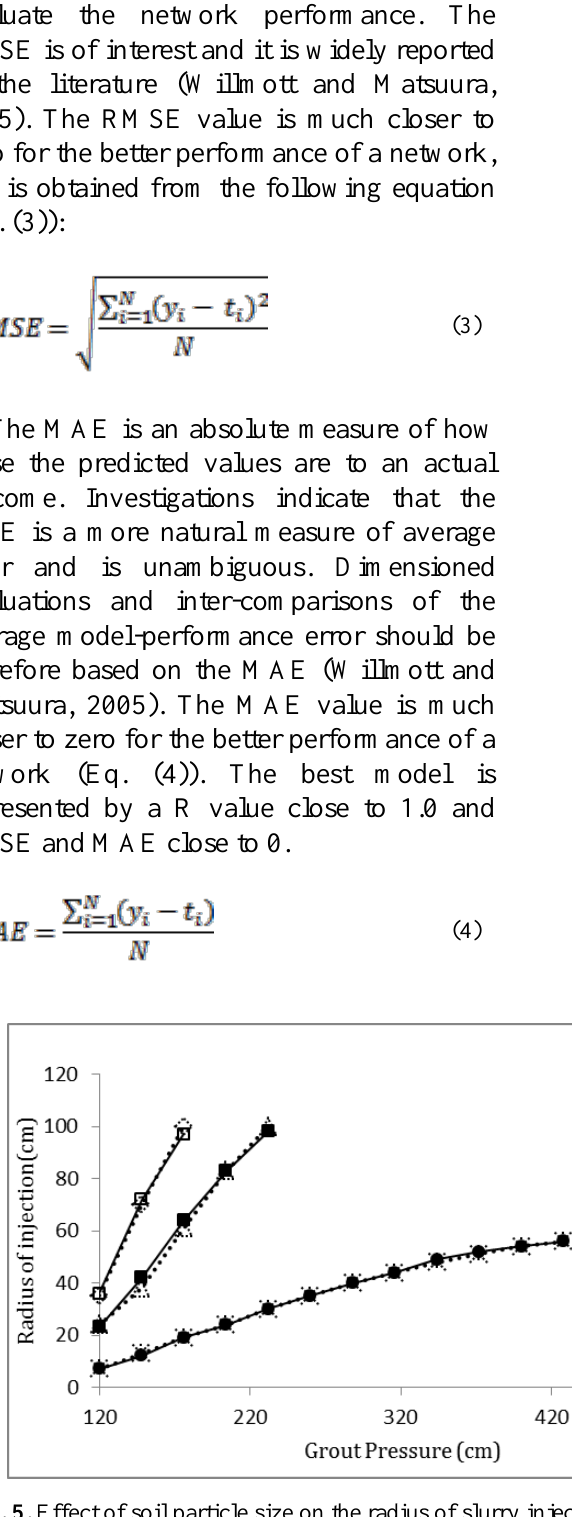
Fig. 5. Effect of soil particle size on the radius of slurry injection based on experimental tests and ANN predictions (W/S=1 and